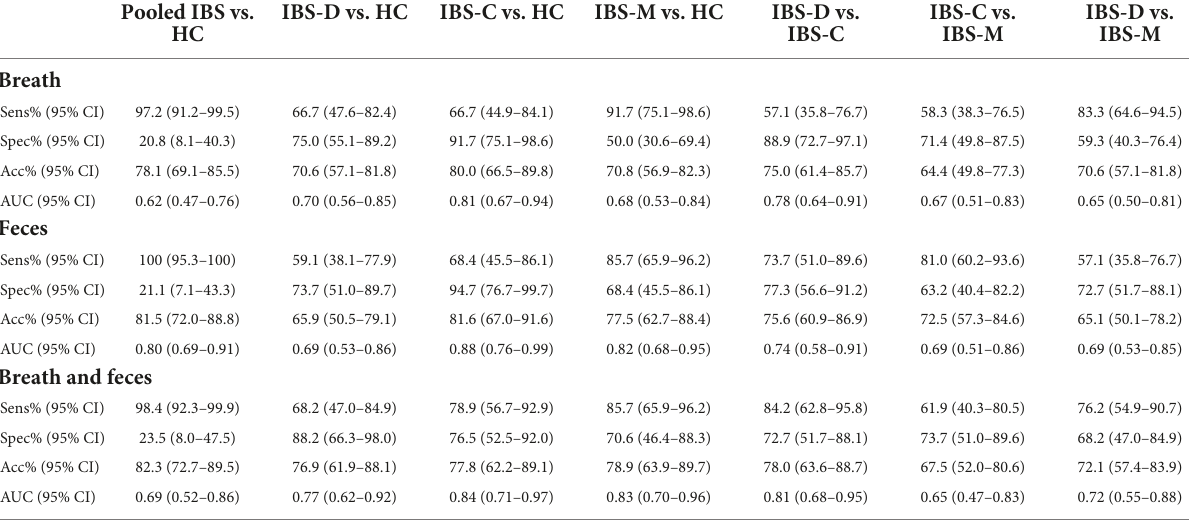
TABLE 3 Differentiating models based on VOC pattern. Pooled IBS vs.